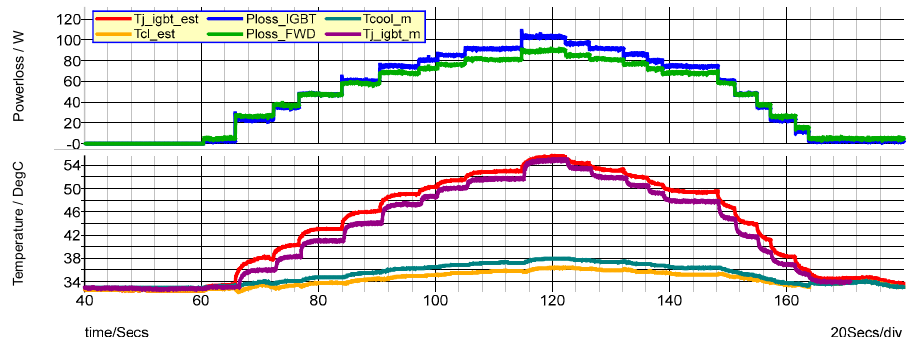
Figure 12. The waveform of losses and IGBT junction temperature under di ff erent currents.